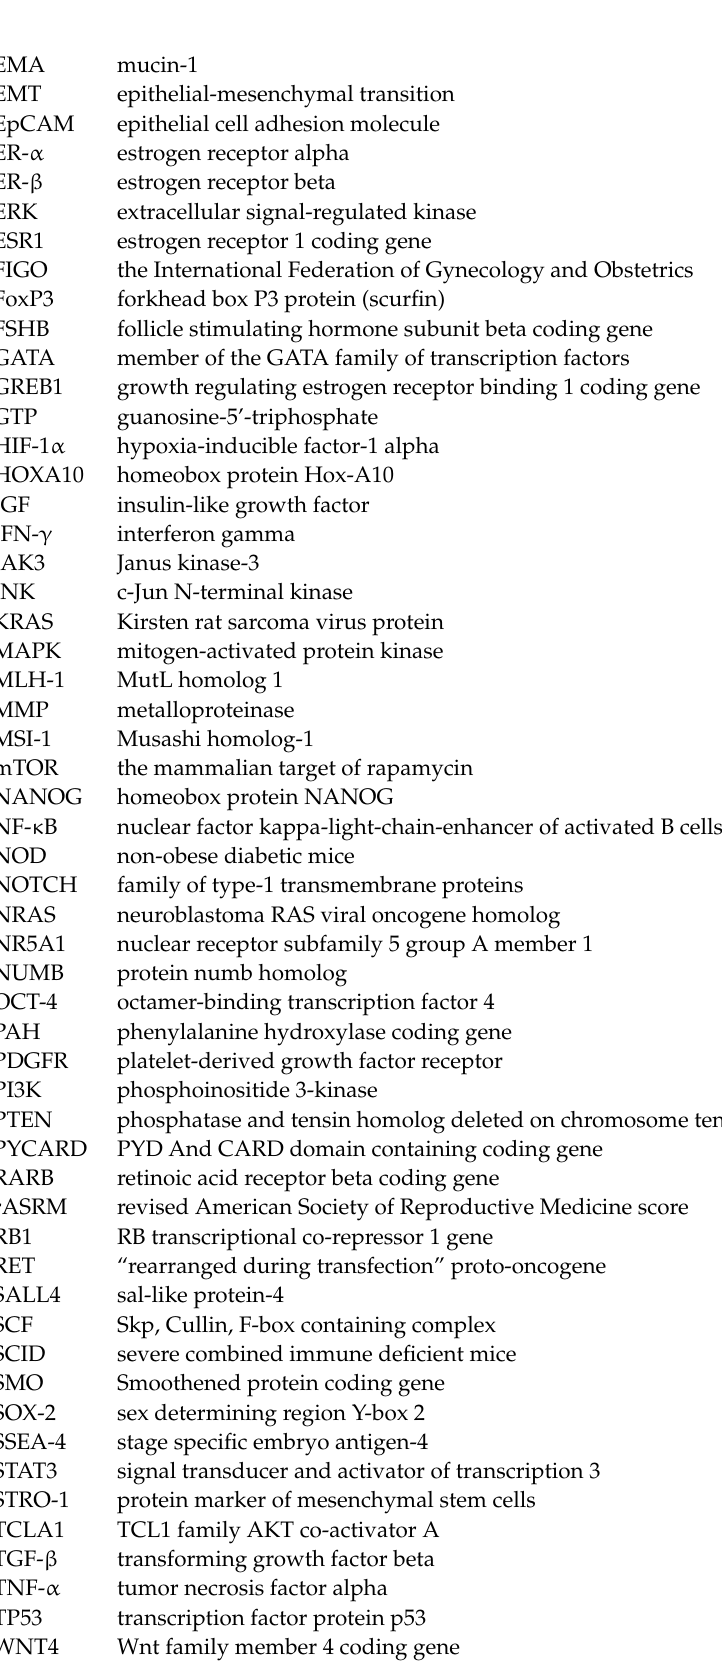
the International Federation of Gynecology and